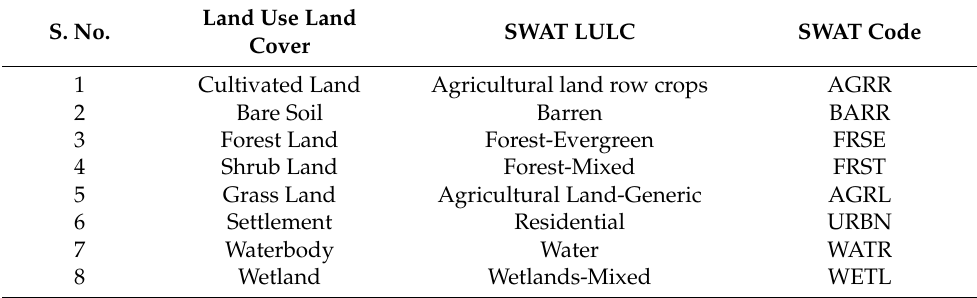
Table 4. Land use classification of the Fincha’a watershed, and the corresponding SWAT code. Land Use Land SWAT LULC SWAT Code S. No. Cover 1 Cultivated Land Agricultural land row crops AGRR Bare Soil Barren BARR Forest Land Forest-Evergreen FRSE Shrub Land Forest-Mixed FRST Grass Land Agricultural Land-Generic AGRL Settlement Residential URBN Water WATR Wetland Wetlands-Mixed WETL